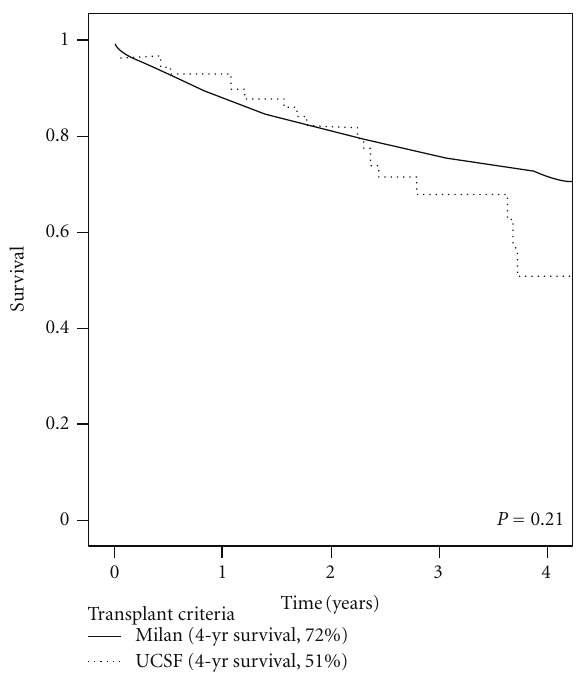
Figure 1: Survival analysis of HCC patients treated with liver transplantation stratified by Milan and UCSF selection